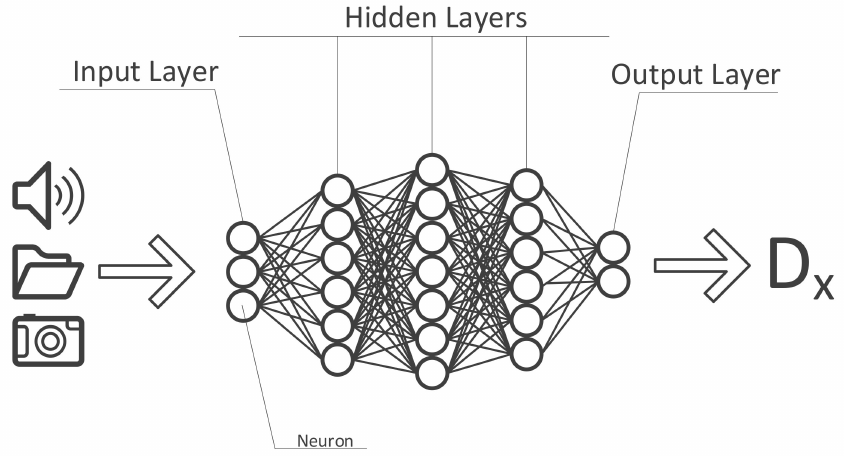
Figure 3. Structure of an artificial neural